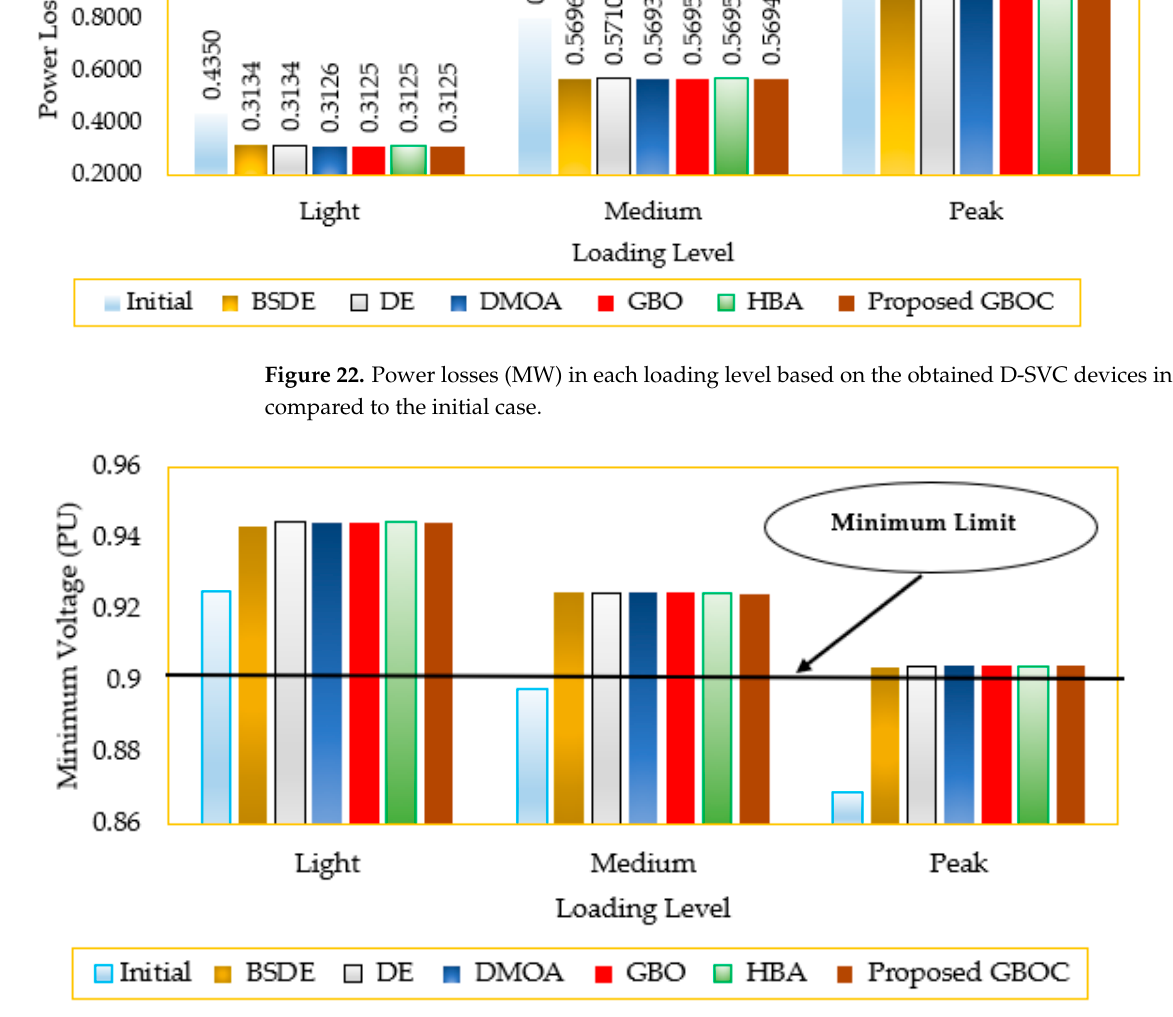
Figure 23. Minimum voltages for the IEEE 119-distribution system via the GBOC versus GBO, SSA, DMOA, DE, and HBA.